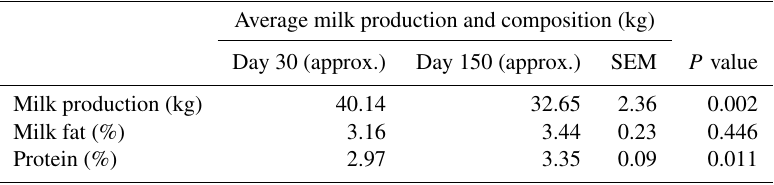
Table 2. Average milk production around days 30 and 150 of standard lactation and milk fat and protein percentage in Holstein cows. Average milk production and composition (kg) Day 30